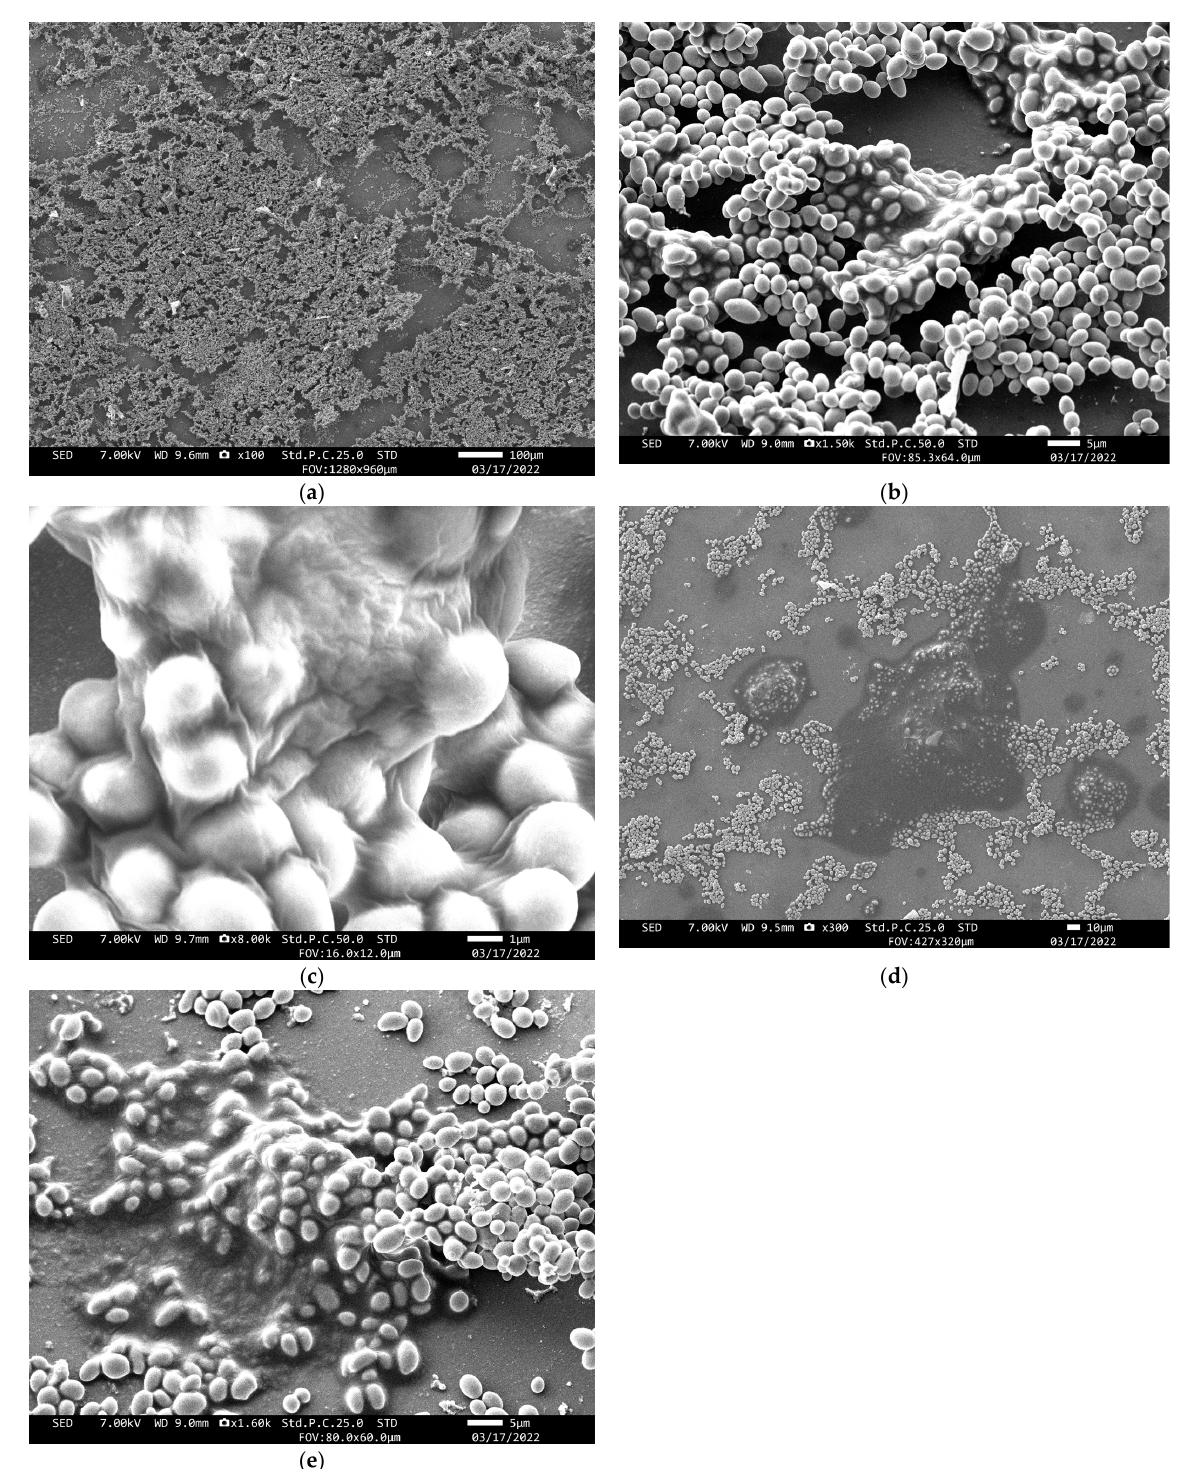
Figure 4. Biofilms of the C. parapsilosis strains were observed via scanning electron microscopy. The pictures ( a – c ) were taken of the P1 strain, and the pictures ( d , e ) were taken of the E2 strain: ( a ) the biofilm (100 × ); ( b ) many fungal cells formed hump-shaped clumps (1500 × ); ( c ) the surface of the clumps (8000 × ); ( d ) other points of the biofilm, and the liquid extracellular matrix produced on the surface of the preparation (300 × ); and ( e ) many fungal cells adhered to adhesive substances in the extracellular matrix (1600 ×